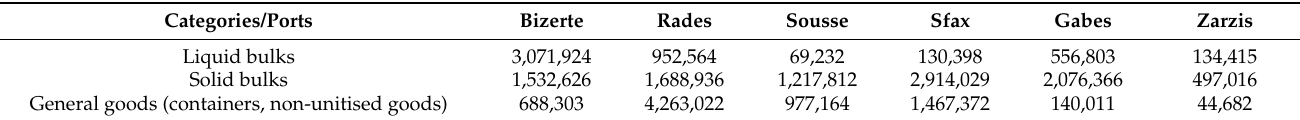
Table 1. Structure of Tunisian seaports traffic in 2016